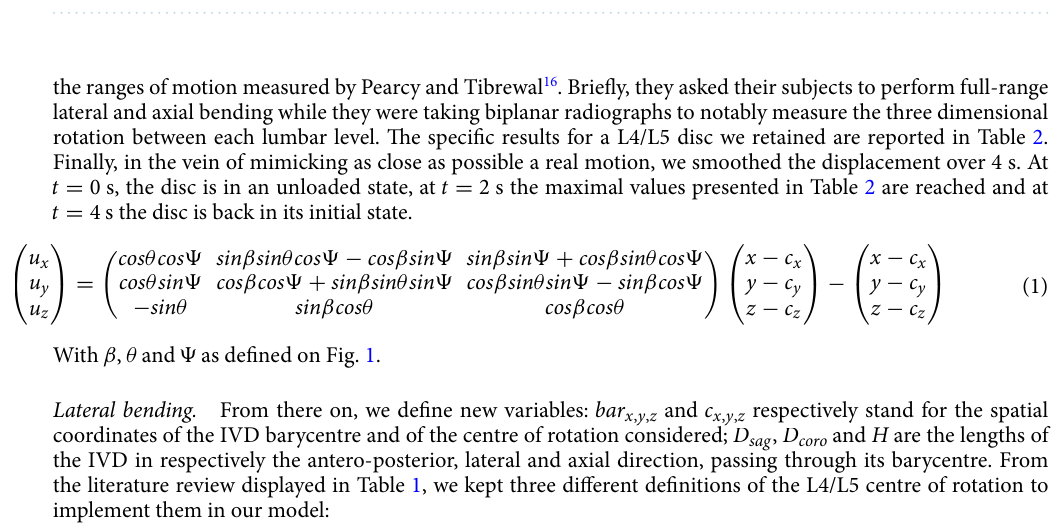
Table 2. Prescribed rotations in the anatomical planes for LB and AR simulations. Source: Pearcy and Tibrewal 16 .